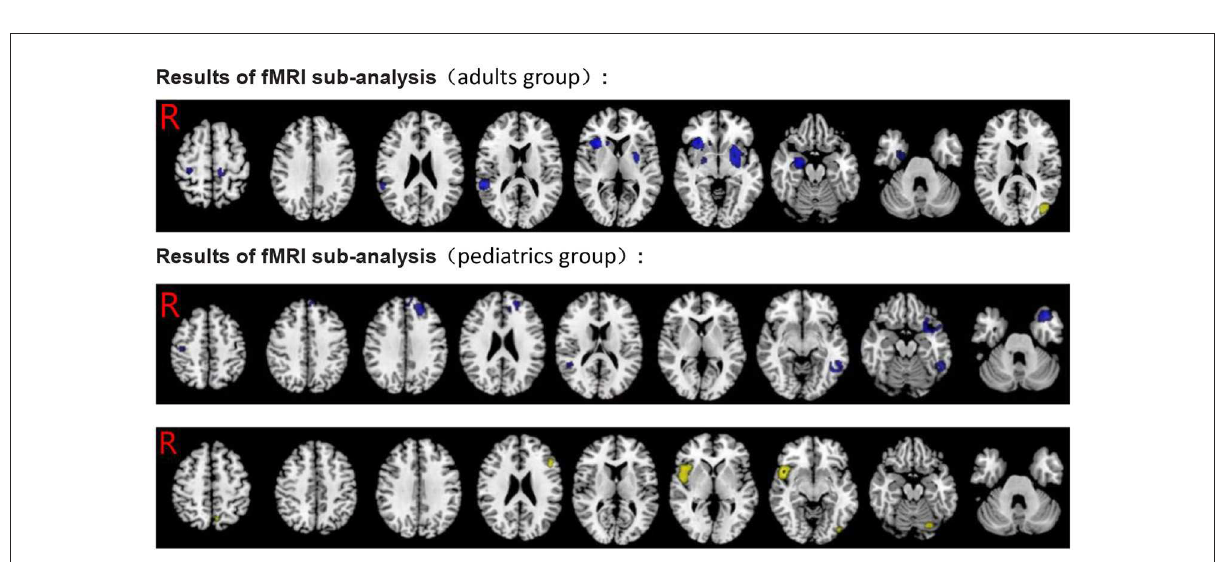
FIGURE5 Results of subgroup analysis of fMRI for ADHD. Blue, hypoactivation in ADHD; Yellow, overactivation in